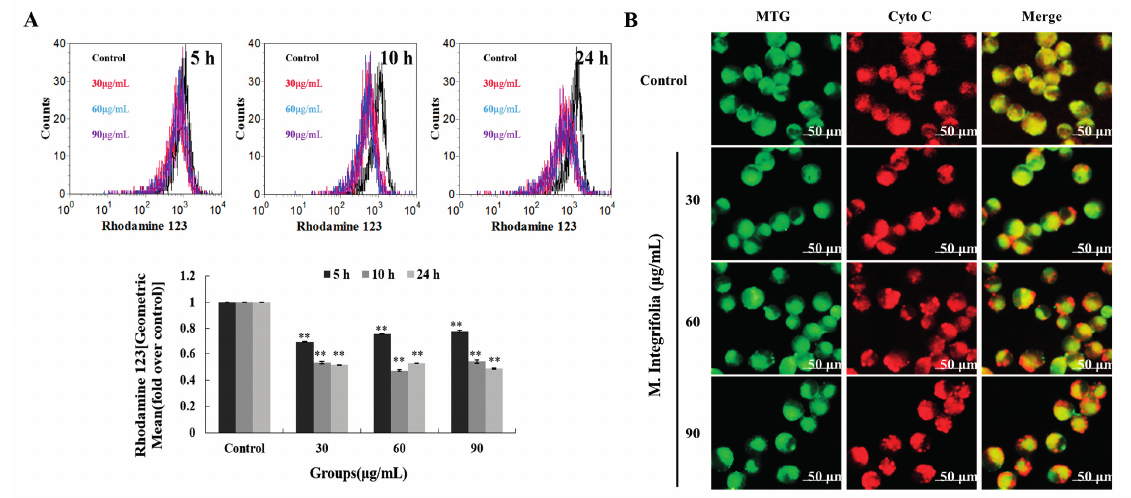
Figure 4. The alterations of mitochondria triggered by M. integrifolia. ( A ) Effect of M. integrifolia on mitochondrial membrane potential of K562 cells. Cells were treated with M. integrifolia for 5, 10 and 24 h. Then the cells were labeled with Rhodamine 123 and analyzed by fl ow cytometry. Histograms show number of cell channel (vertical axis) vs. Rhodamine 123 fl uorescence (horizontal axis). ** p < 0.01 vs. Control. (Error bars = S.D., n = 3); ( B ) Detection of release of cytochrome C from mitochondria in K562 cells after M. integrifolia